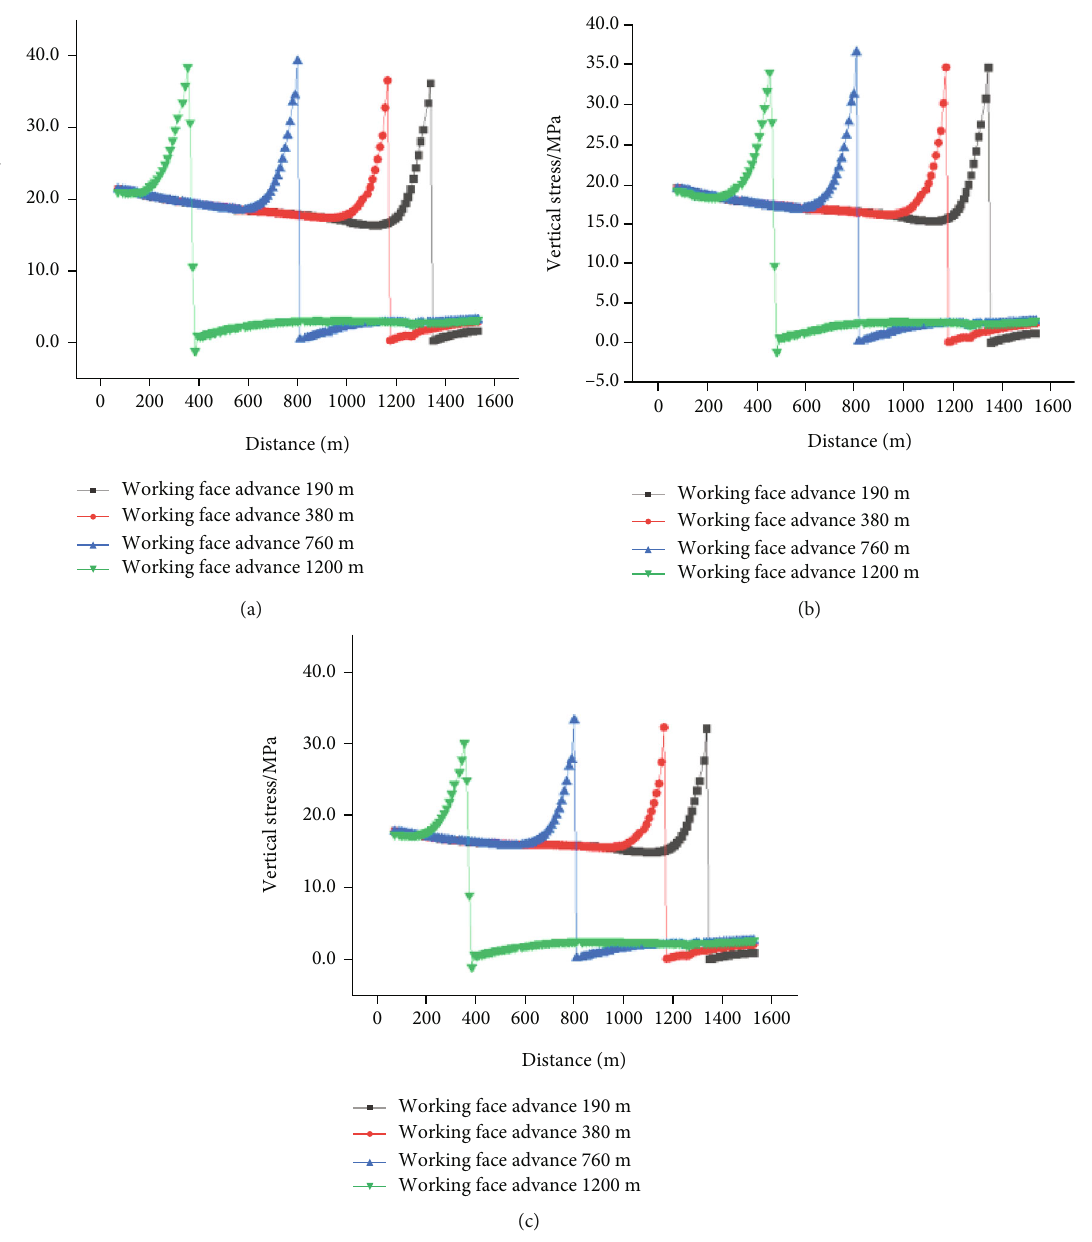
Figure 10: Vertical stress change in di ff erent pillar widths: (a) 5 m; (b) 25 m; (c)